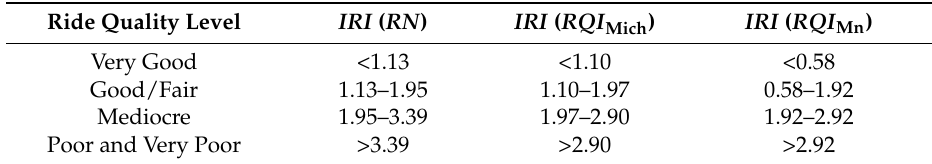
Table 7. IRI thresholds based on the different ride quality indices limit values in (m/km).